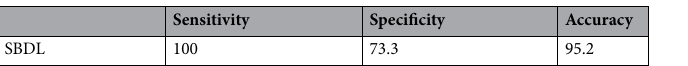
Table 3. The index of tongue-crack classification model based on SBDL network (%).